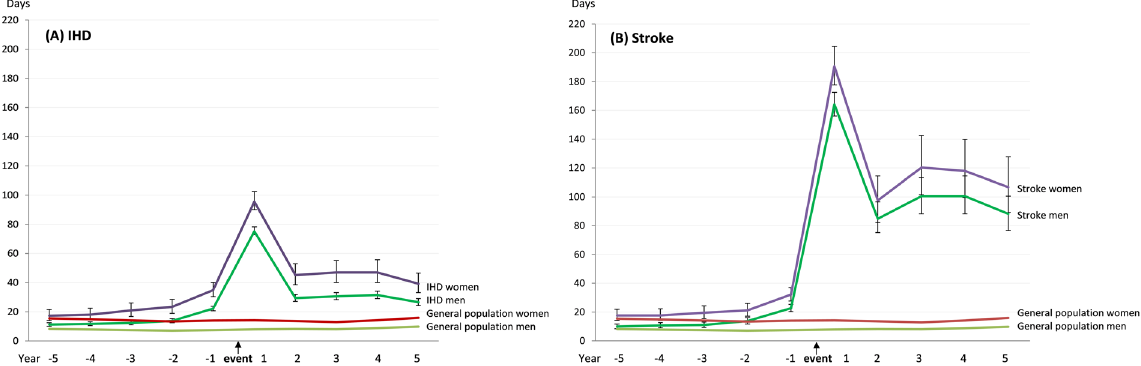
Figure 1. Mean days (95% confidence intervals) of work disability among men and women 5 years before and 5 years after newly diagnosed cardiovascular disease and men and women in the general population; IHD (Panel A) or stroke event (Panel B), unadjusted estimates * . * Adjusted estimates are shown in Supplementary Figure 2.